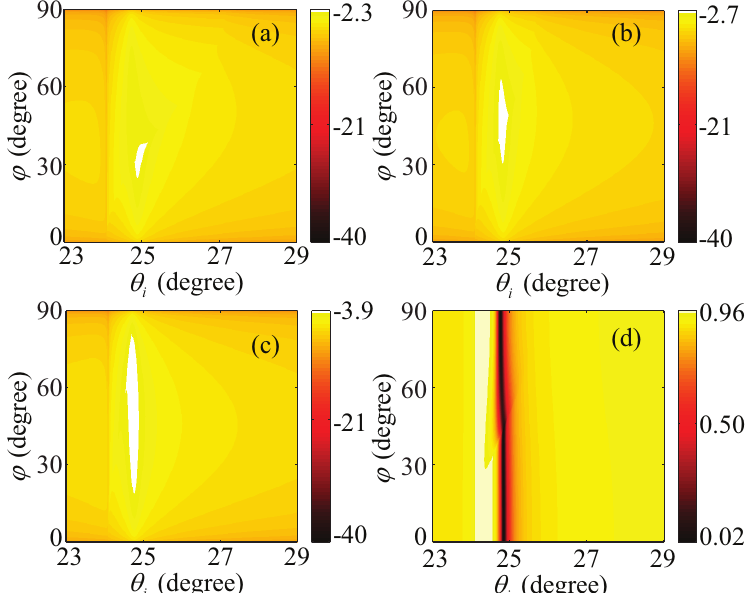
Figure 6. Reflectivity in the Kretschmann configuration with different weakly positive anisotropic uniaxial dielectric claddings. ( a – c ) the color bar on a log 10 scale, i.e. , ) ; and ( d ) R lg ( R . TE TM = 2 . 0 , ε = 2 . 5 ; ( b , d ) ε = 2 . 0 , ε = 2 . 25 ; and ( c ) ε ( a ) ε o e o e